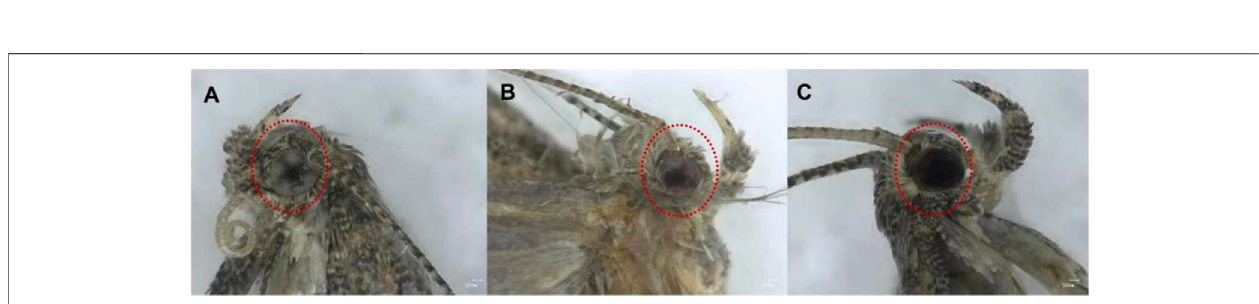
FIGURE 4 | CRISPR/Cas9 induced mutations at the cinnabar gene in Tuta absoluta F1 individuals. (A) Wild-type eye colour in control T. absoluta. (B) Cinnabar mutant adults showed red eyes, and (C) mutant adults showed mosaic eye colour.